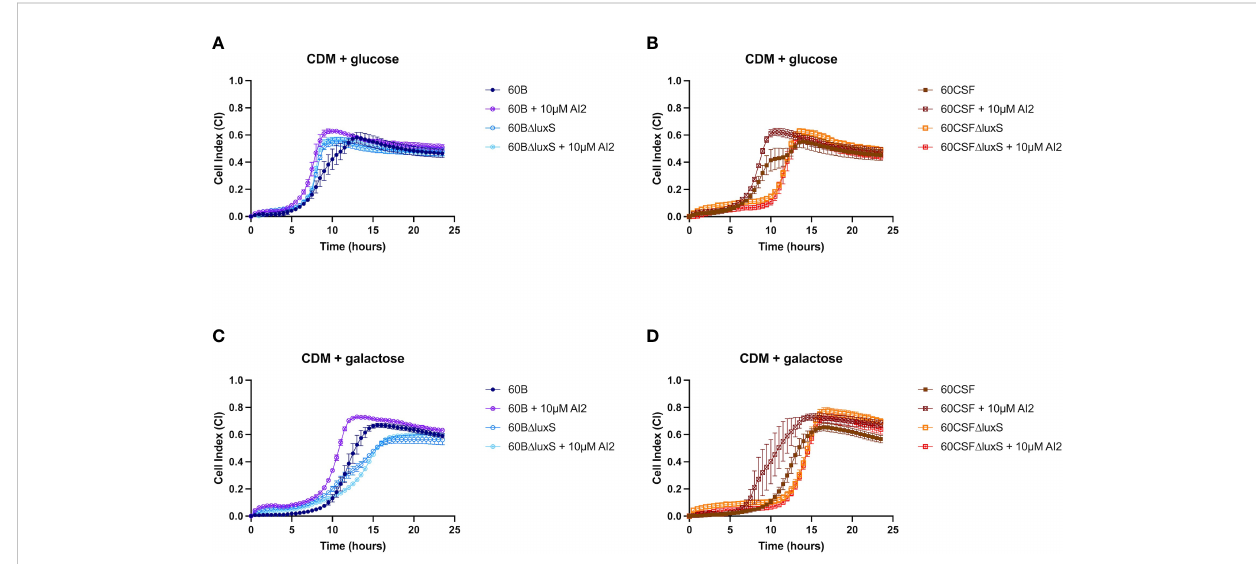
FIGURE 7 Bio fi lm formation of 60B, 60CSF, 60B D luxS and 60CSF D luxS strains. Bacteria were cultured overnight on BA plates before being diluted to a fi nal OD 600 of 0.05 in CDM + 0.5% glucose ± 10 µM AI-2 (A, B) or CDM + 0.5% galactose ± 10 µM AI-2 (C, D) . 200 µL of each bacterial strain in each culture medium was placed into wells of a xCELLigence E-plate, with the plate being placed in the cradles of the RTCA-DP platform and incubated at 37°C with 5% CO 2 . Bio fi lm formation was determined by measuring cell index (CI) every 15 min over 24 h using real-time cell analysis (RTCA) xCELLigence technology. Data are mean CI ± standard error mean (SEM) from three independent assays, each performed in triplicate.